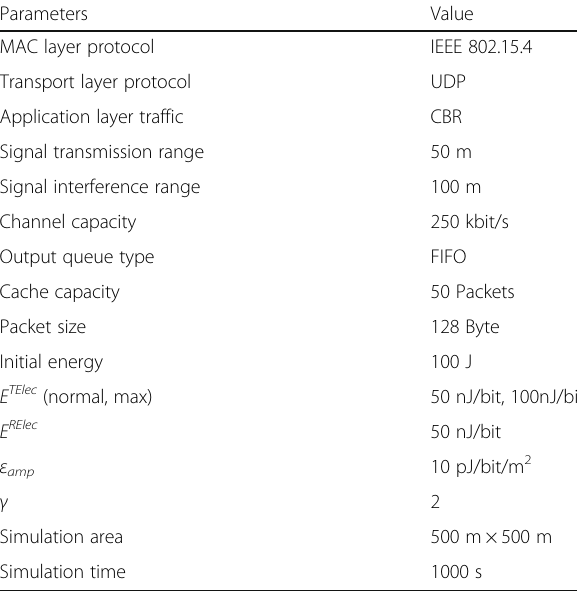
Table 2 Simulation parameters